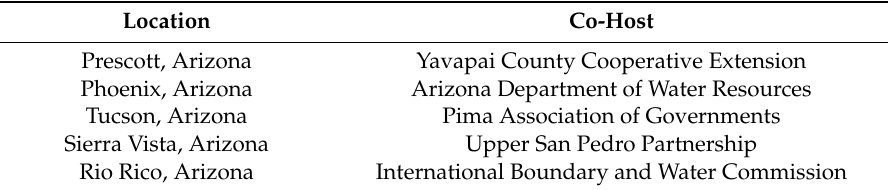
Table 2. Locations and co-hosts, transferability